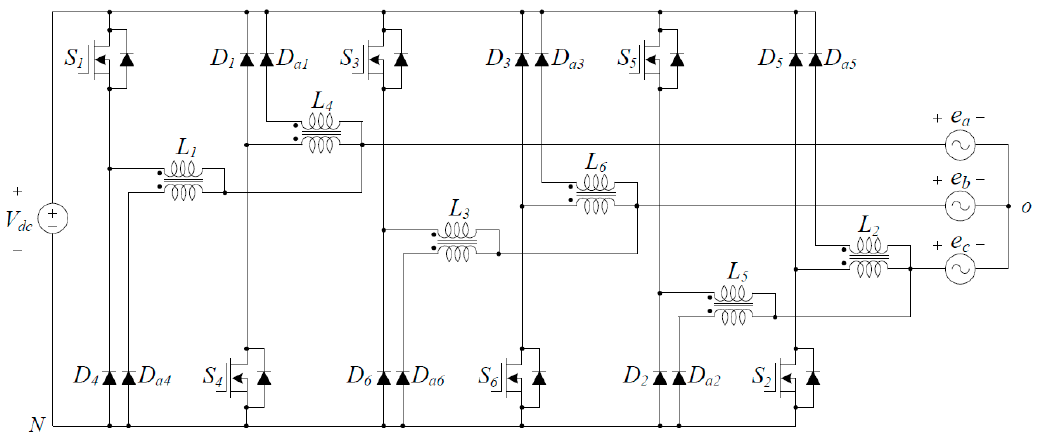
Figure 2. Circuit diagram of the proposed inverter.